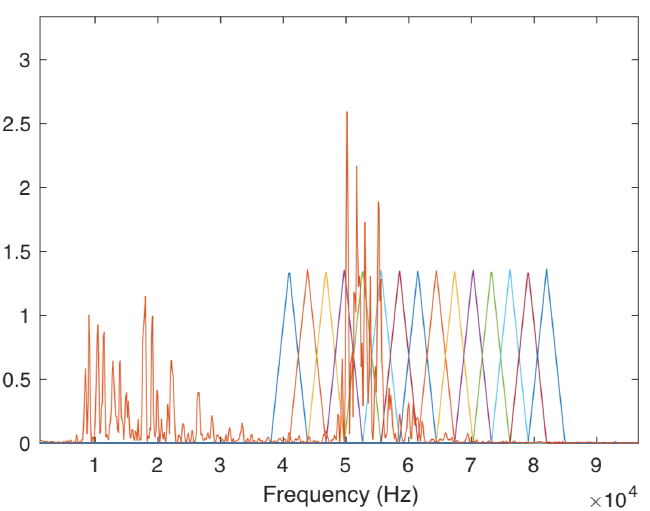
Figure 10. Frequency representation of a sample bat call being filtered with the linear scale triangular filter bank for the coefficients